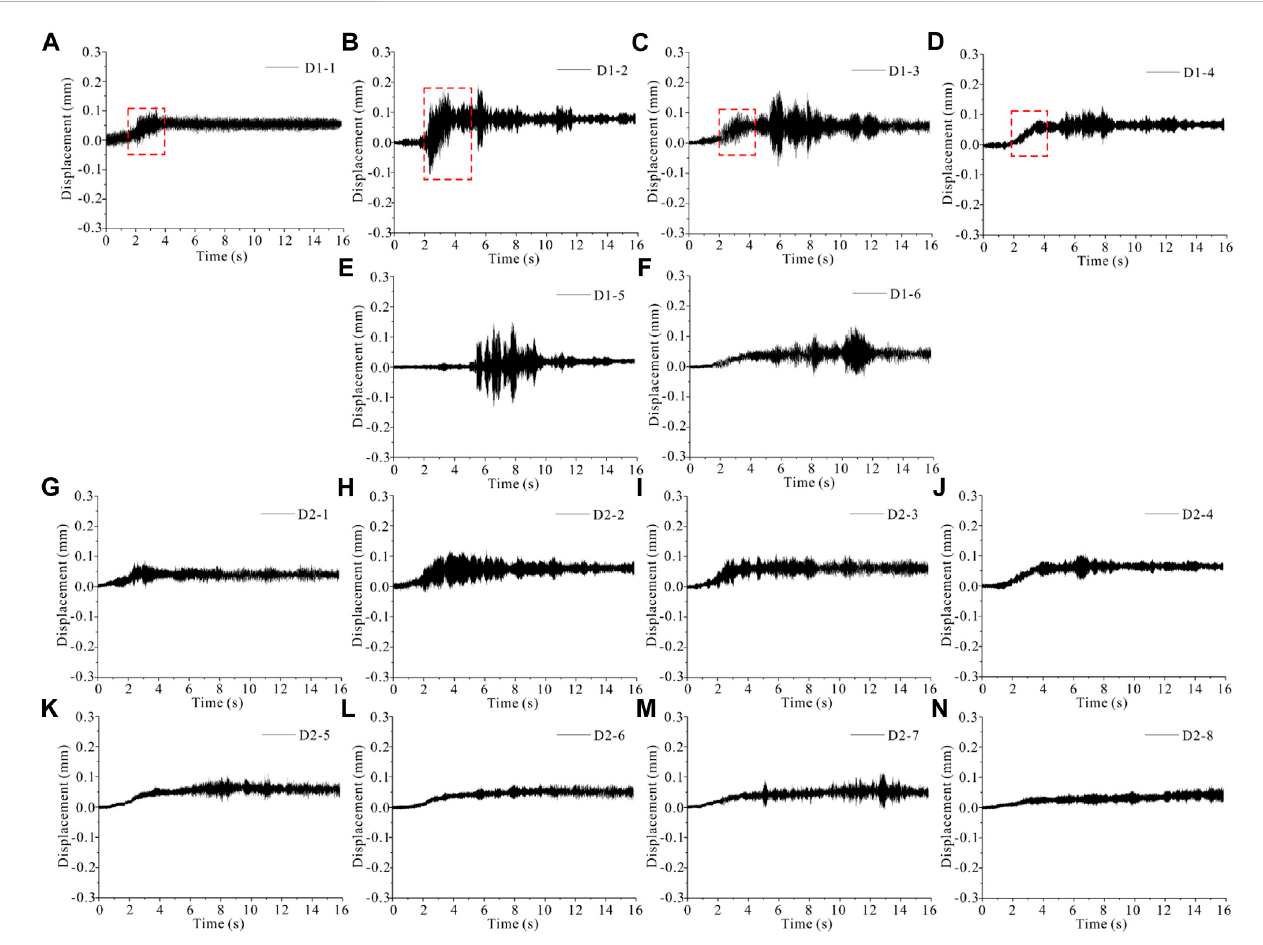
FIGURE 11 Dynamic displacement-time curves on subgrade surface ( (A – D) in the Hanging wall, (E,F) in the Footwall) and on ground surface ( (G – J) in the Hanging wall, (K – N) in the